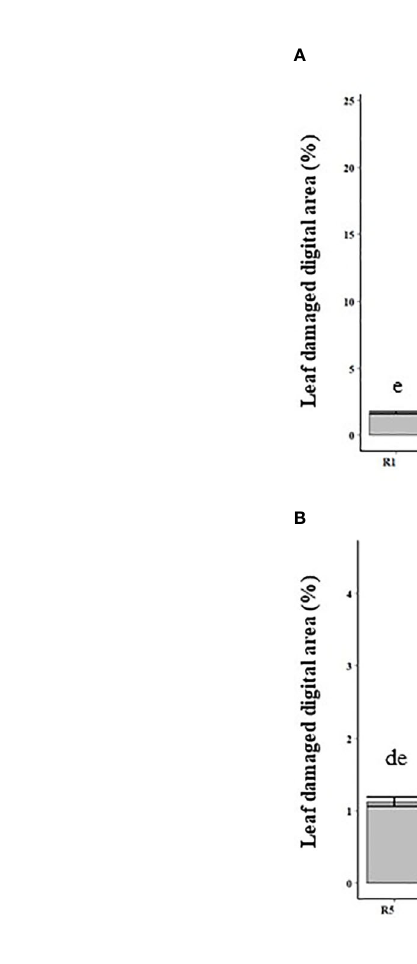
FIGURE 3 Quanti fi cation of the leaf area affected at 96 hours post inoculation with Peyronellaea pinodes (A) and Didymella pinodella (B) . The data are presented as mean ± SEM. Different letters on each bar signi fi es statistical signi fi cance among genotypes at P < 0.05 level for P. pinodes and D . pinodella. R1, PBA Wharton; R2, 11HP302-12HO-1; R3, 05H161-06HOS2005-BOG09-2; R4 09HP216-10HO2-3; S1, OZP1604; S2, 11HP160- 12HO-1; S3, PBA TWILIGHT; S4, 10HP249-11HO-7; R1-4 partially resistant and S1-4, susceptible to P. pinodes. R5, 10HP249-11HO-7; R6, PBA WHARTON; R7, PBA TWILIGHT; R8, 11HP420-12HO-13; S5, WAPEA2211; S6, OZP1604; S7, PBA OURA; S8, 09HP216-10HO2-3; R5-8 partially resistant and S5-8 susceptible to D . pinodella